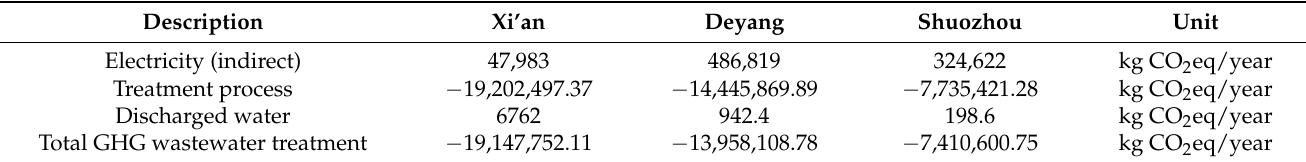
Table 3. Detailed greenhouse gas assessment data of ECAM in wastewater treatment stage of Xi’an, Deyang and